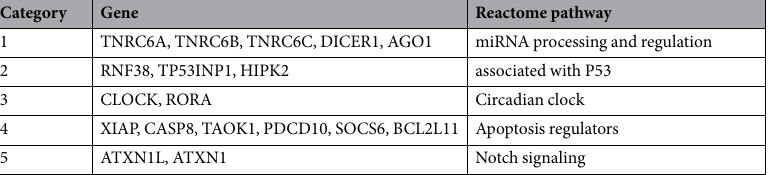
Table 1. A subset of PTEN ceRNA predictions organized in different categories based on Reactome